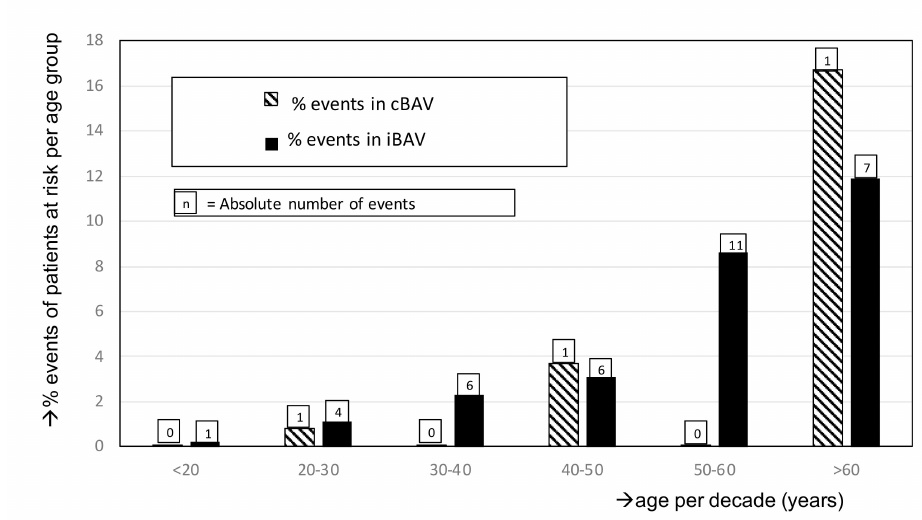
Figure 2. Aortic events in 499 BAV patients, as percentage of total in each age group for iBAV group and cBAV group. The vertical axis represents the percentage of events, calculated as the total patients at risk per specific age group of iBAV and cBAV